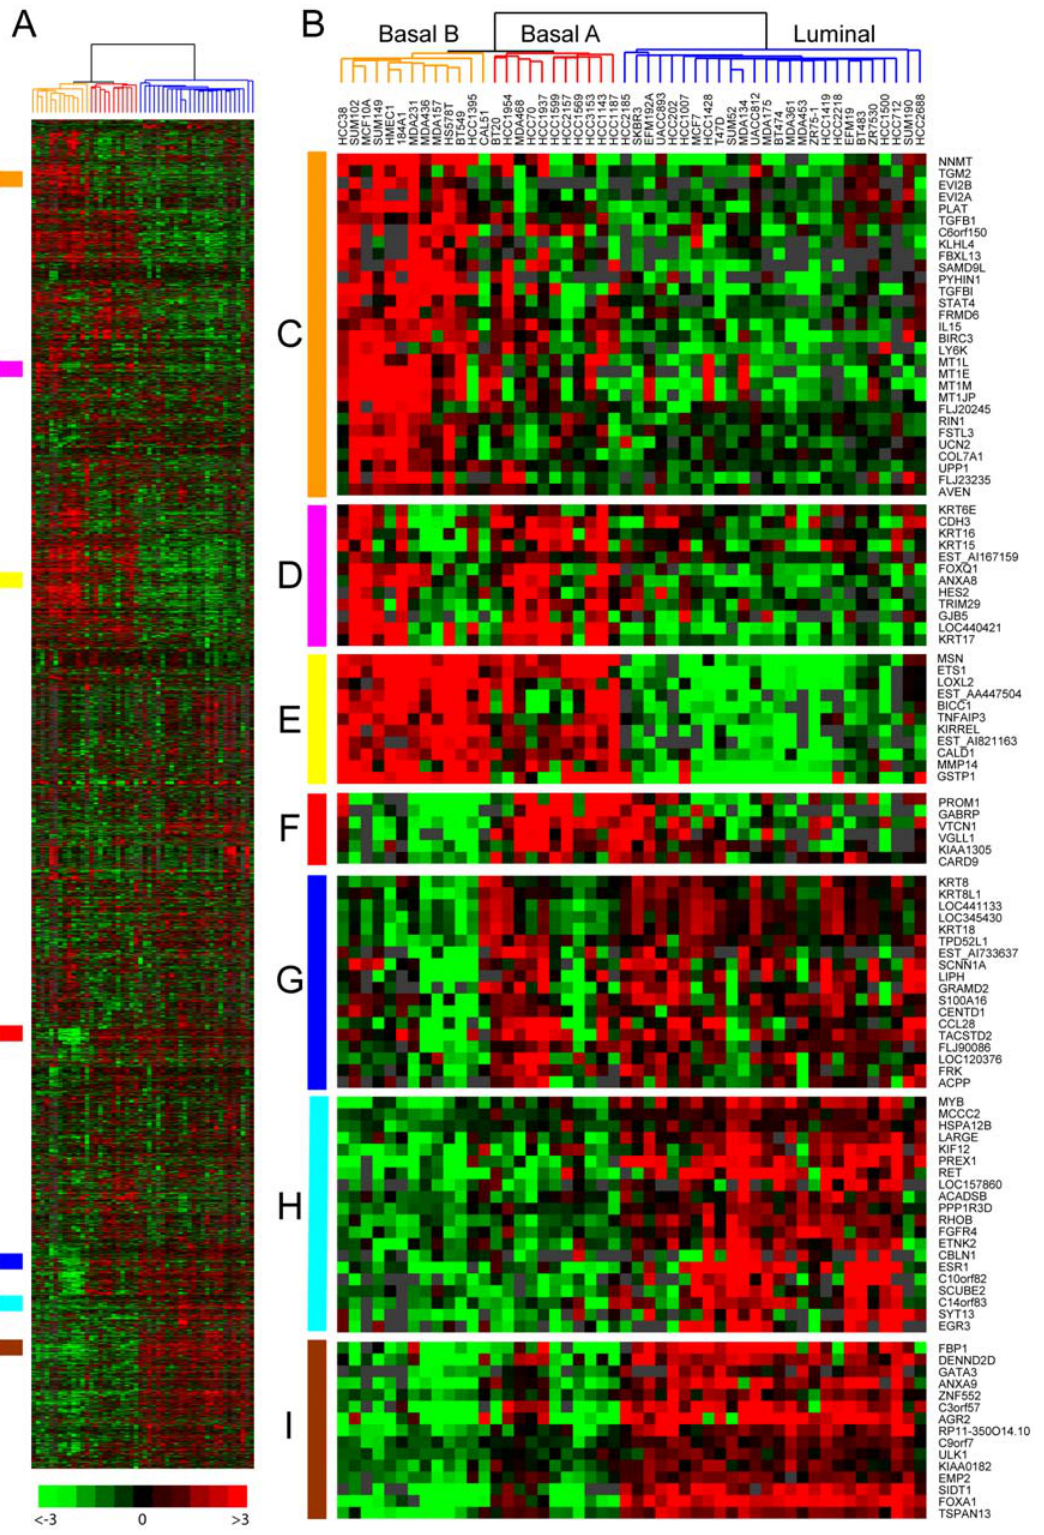
Figure 1. Clustering of expression profiles defines breast cancer cell line subtypes. (A) Thumbnail ‘‘heatmap’’ of two-way hierarchical clustering of 50 breast cancer cell lines (columns) and 8,750 variably expressed genes (rows) (data available as Table S1). Gene expression ratios are depicted by log 2 pseudocolor scale shown; gray represents poorly measured data. (B) Enlarged view of the sample dendrogram. Clustering stratifies cell lines into two main groups, luminal (blue dendrogram branches) and basal, the latter further subdivided into two subgroups, basal A (red) and basal B (orange). (C–I) Selected gene expression patterns extracted from the cluster; corresponding locations in the thumbnail are indicated by the vertical colored bars. (C) Basal-B; (D) Basal cytokeratins; (E) Basal; (F) Basal-A; (G) Luminal cytokeratins; (H) ER-associated; (I) Luminal differentiation. doi:10.1371/journal.pone.0006146.g001 PLoS ONE |